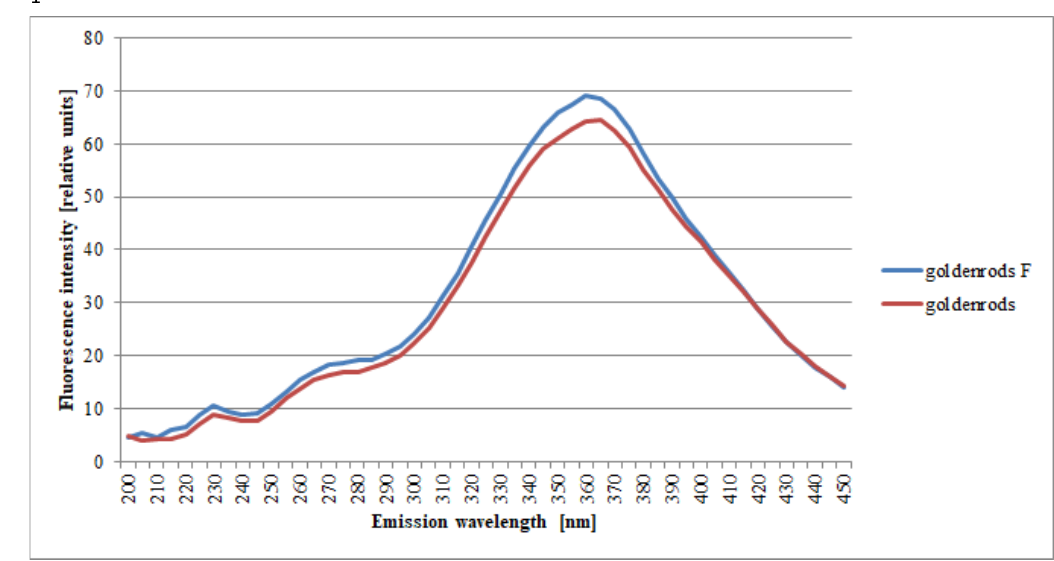
Figure 4. Normalized fluorescence emission spectra of different botanical origins of filtered and unfiltered honeys ( a –acacia, b –phacelia, c –buckwheat, d –lime, e –multifloral, f –rape, g –dandelion, h –honeydew, and i –goldenrods) F-filtered and unfiltered. Source: own research. Table 1. Mean emission intensities over characteristic spectral regions for filtered and unfiltered honeys of different types.